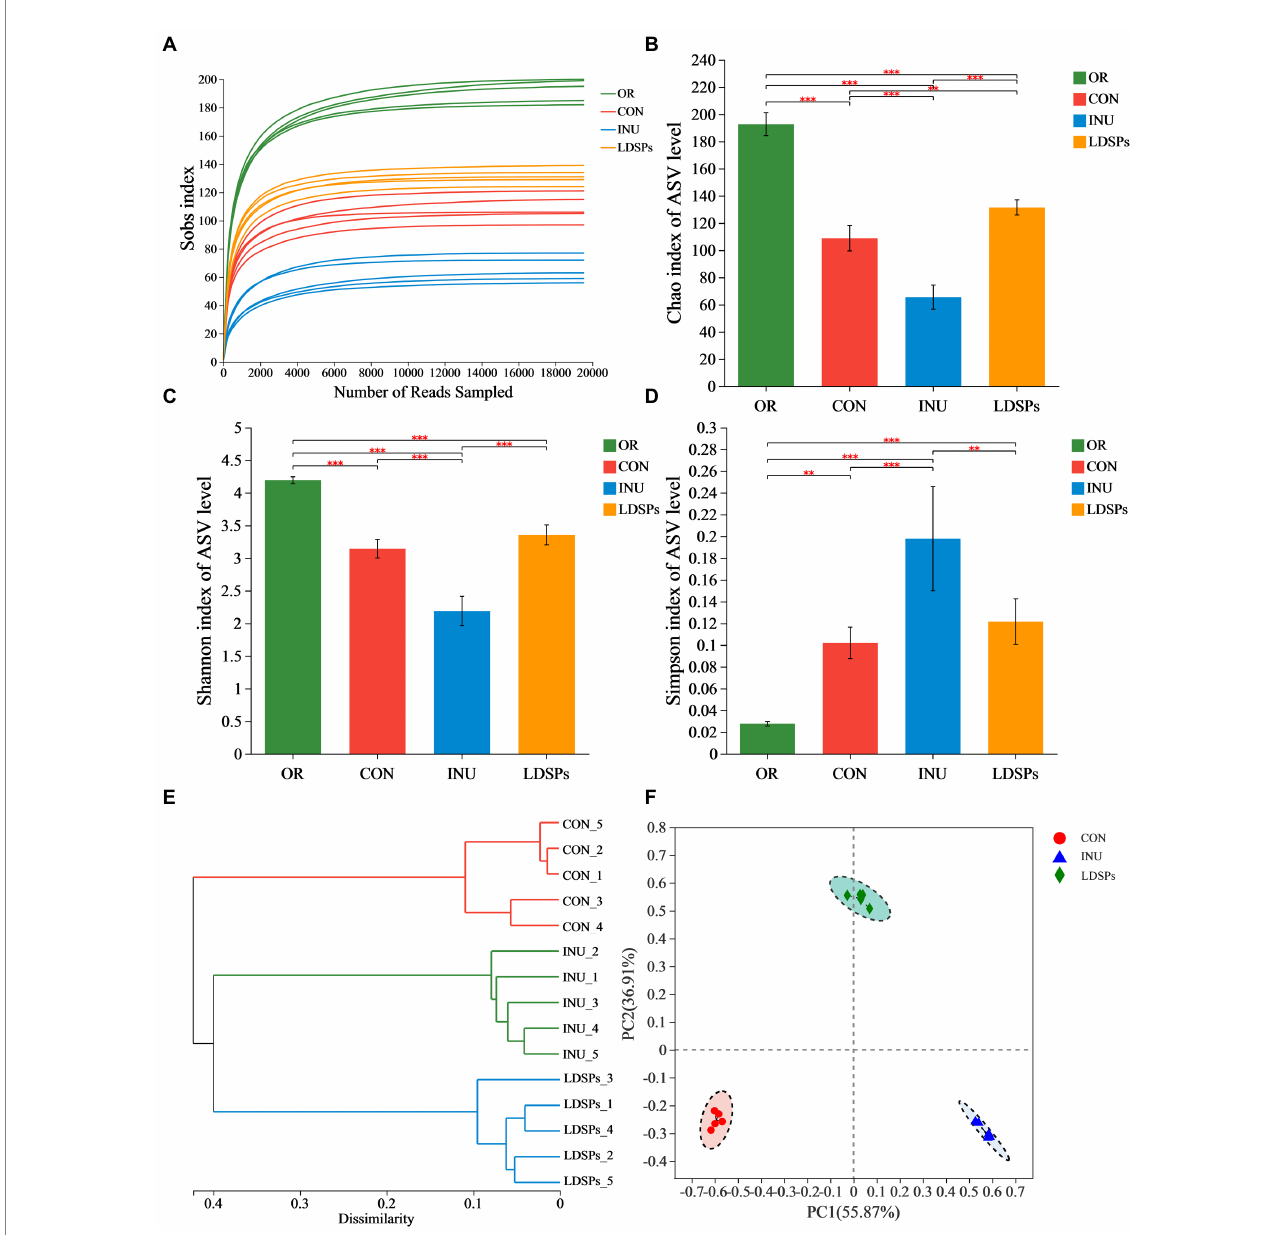
FIGURE 2 Alpha diversity analysis using the Student’s t -test for the Ace (A) , Chao (B) , Shannon (C) , and Simpson indices (D) and β -diversity analysis using UPGMA for hierarchical clustering (E) and ANOSIM for PCoA (F) on ASV level of gut microbiota in groups ( n = 5) after 24 h of fermentation. * p < 0.05, ** p < 0.01, and *** p < 0.001, respectively; OR, the initial sample group, CON, the blank control (no additional carbon source supplement), INU, the positive control (INU supplement), and LDSPs, the experimental group (LDSPs supplement); ANOSIM, analysis of similarities; PCoA, principal co-ordinate